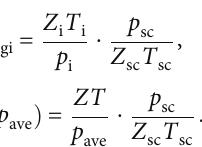
Figure 3: Pseudoreduced compressibility ( C 0.2 to